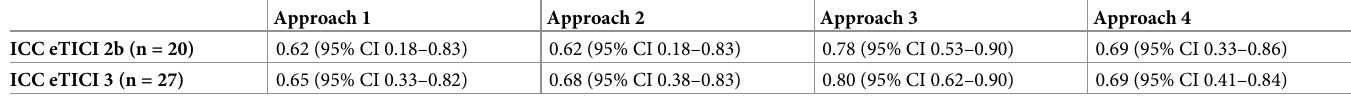
Table 2. Volumetric agreement for patients with eTICI 2b vs. eTICI 3.